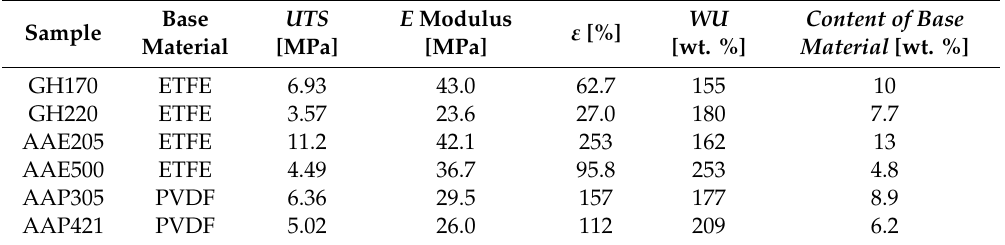
Table 1. Result of the tensile strength tests, water uptake WU and fraction of base